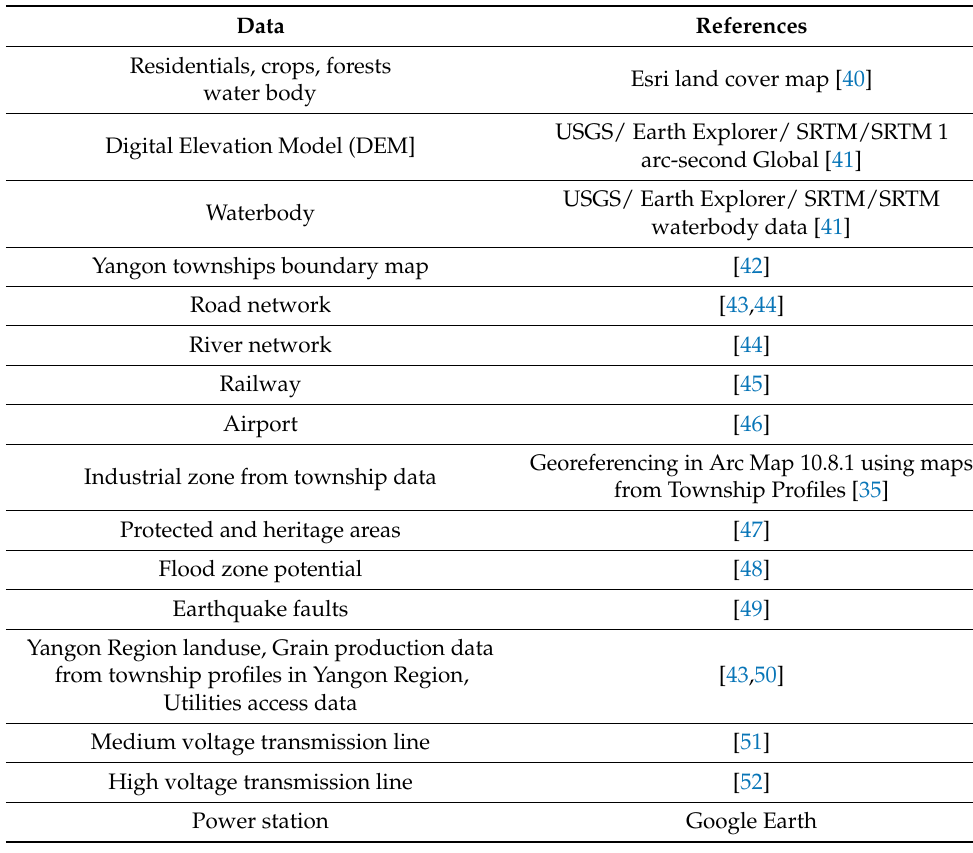
Table A1. Spatial and Non-Spatial Data.